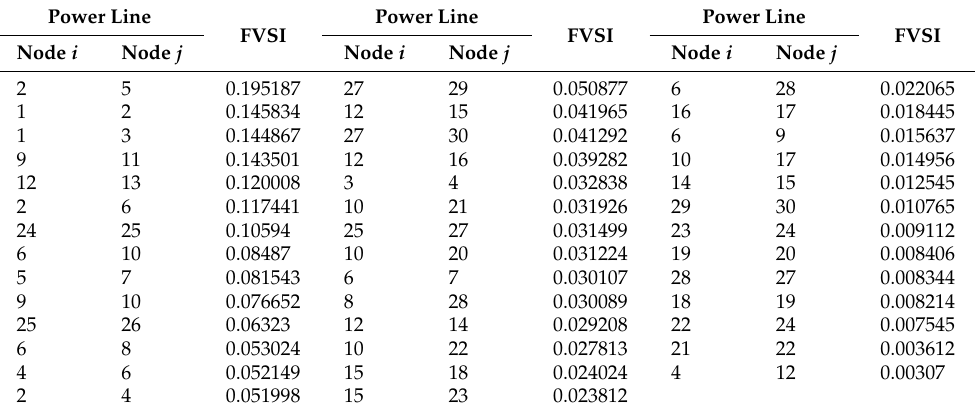
Table 2. FVSI for IEEE 30-bus-bar system before contingency scenarios.